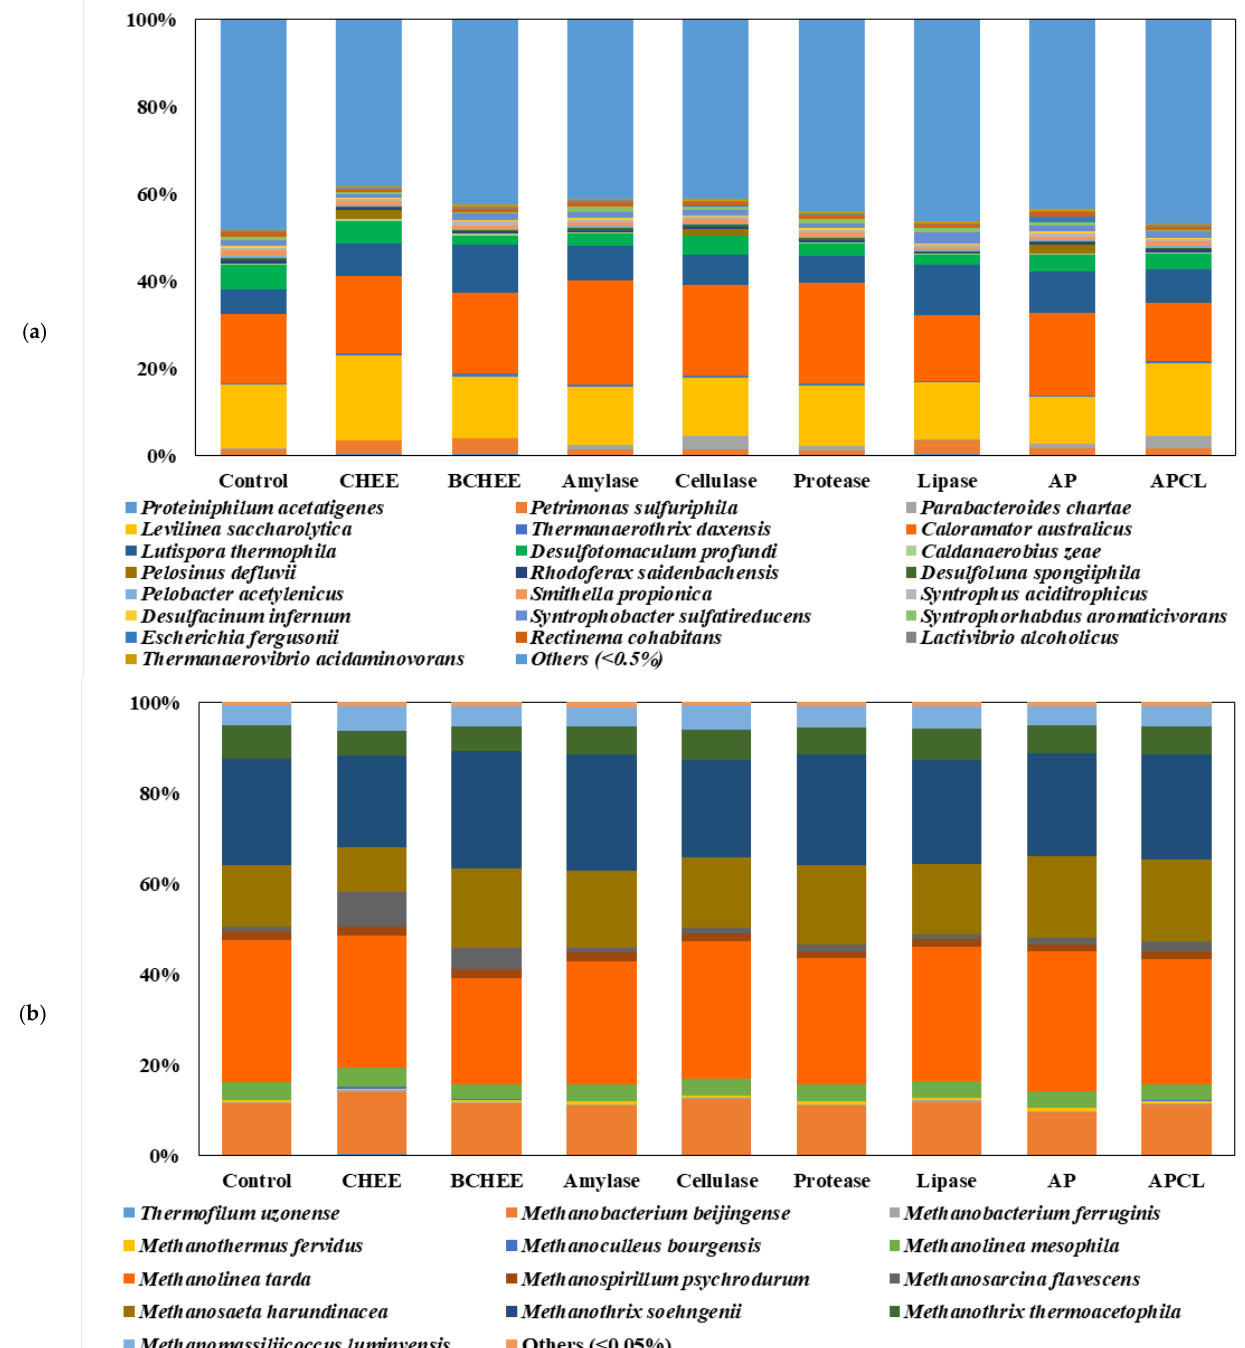
Figure 3. Relative abundance of ( a ) bacteria and ( b ) archaea at the species level in batch tests for CH 4 production with different enzymatic pretreatments.